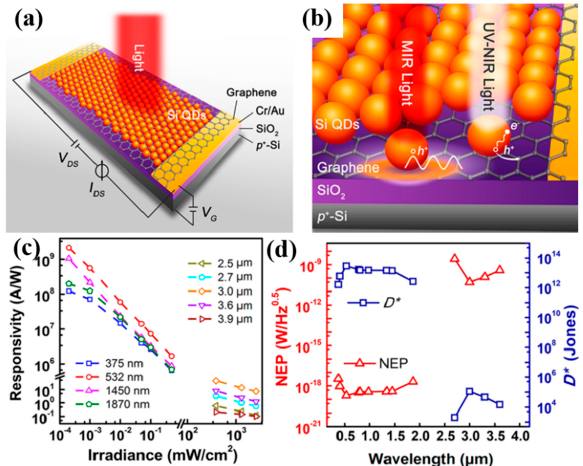
Figure 6. ( a ) Schematic diagram of B-doped Si-quantum dots (QDs)/graphene PDs. ( b ) Two different optical phenomena of B-doped Si QDs. ( c ) The irradiance power-dependent responsivity of the Si-QD/graphene PDs with different laser wavelengths at V G = 0 V and V DS = 1 V. ( d ) The spectral dependence of the noise equivalent power (NEP) and D* of the PDs. The measurements were performed at room temperature and 77 K, respectively